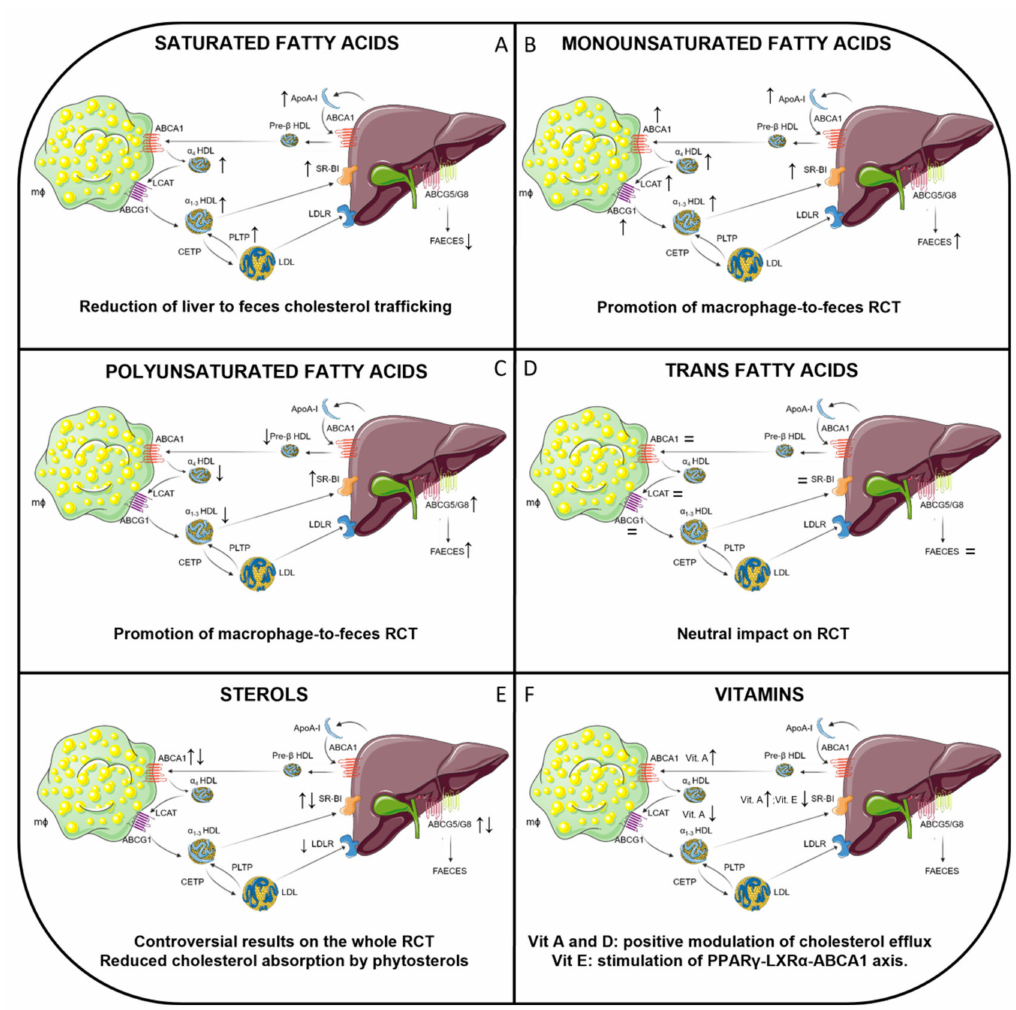
Figure 2. Impact of dietary lipid classes on RCT in animal studies. ( A ) SFA intake induces an increase in the HDL-C, apoA-I, and HDL transport rate in murine models, in parallel with a reduction in the fractional catabolic rate of HDL. Furthermore, a diet rich in palmitic acid increased PLTP activity in hamsters and SR-BI expression in mice expressing human CETP and apoB100. Overall, dietary SFA reduce cholesterol trafficking from the liver to the feces, negatively impacting on total RCT. ( B ) MUFA increase HDL-C and apoA-I levels, LCAT activity, and hepatic SR-BI expression in rats, whereas a diet